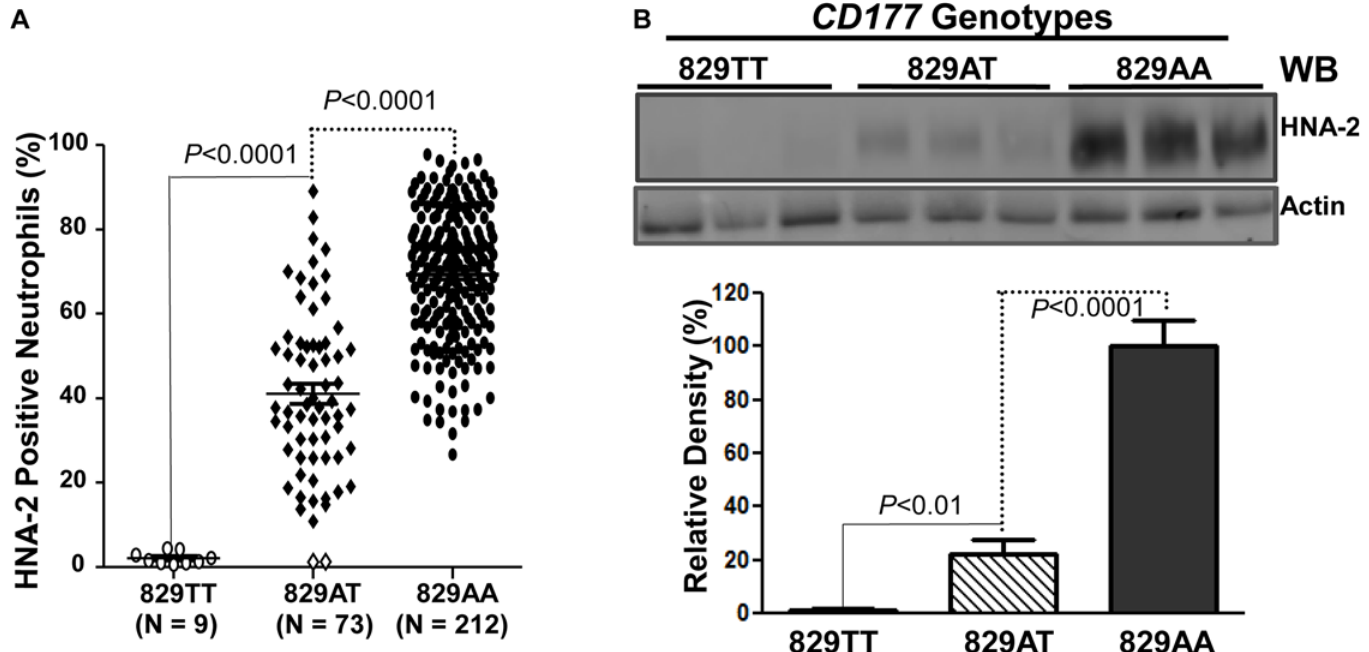
Fig 3. Association of CD177 SNP 829A > T with HNA-2 expression. A). CD177 genotypes were determined with genomic DNA sequence analysis. HNA-2 expression was examined with flow cytometry analysis. All 829TT homozygous donors (829TT, N = 9) were negative for HNA-2. The percentages of HNA-2 positive neutrophils from heterozygous donors (829AT, N = 73) were significantly ( P < 0.0001) lower than those from 829AA homozygous donors (829AA, N = 212). Two heterozygous 829AT donors indicated by the empty diamonds in the middle column were also negative for HNA-2 expression. B ). HNA-2 expression in whole blood leukocytes was assayed in Western blot analyses. Representative blot image is shown (Top panel). No HNA-2 protein could be detected in all 829TT homozygous donors (829TT, N = 9) while heterozygous donors (829AT, N = 9) express significantly less HNA-2 as compared to the 829A homozygous donors (829AA, N = 9) (Lower